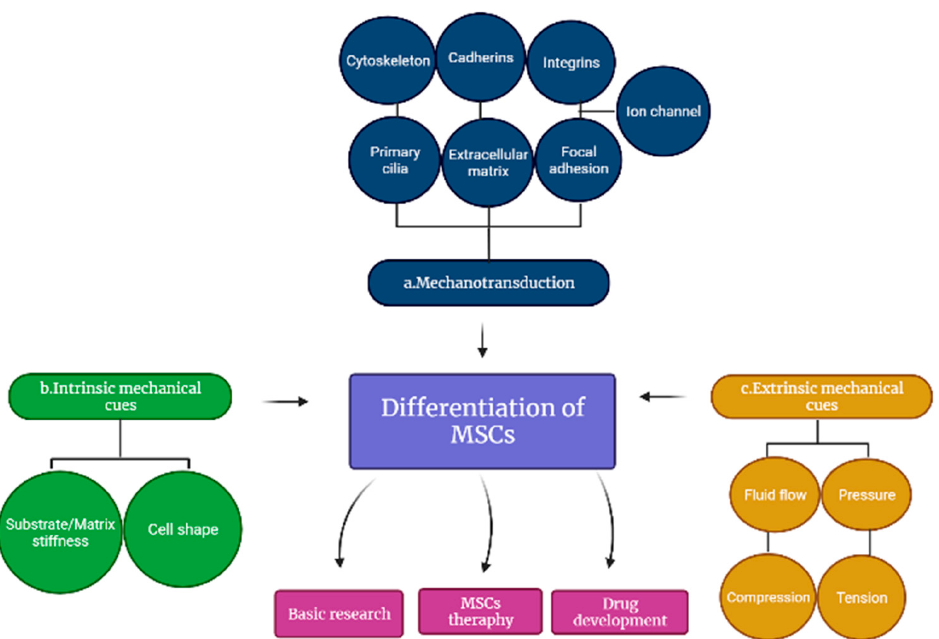
Figure 3. Differentiation of mesenchymal stem cells (MSCs). The differentiation involves ( a ) cell membrane and numerous intracellular components, ( b ) intrinsic and ( c ) extrinsic mechanical cues that regulate the mechanotransduction of MSCs.